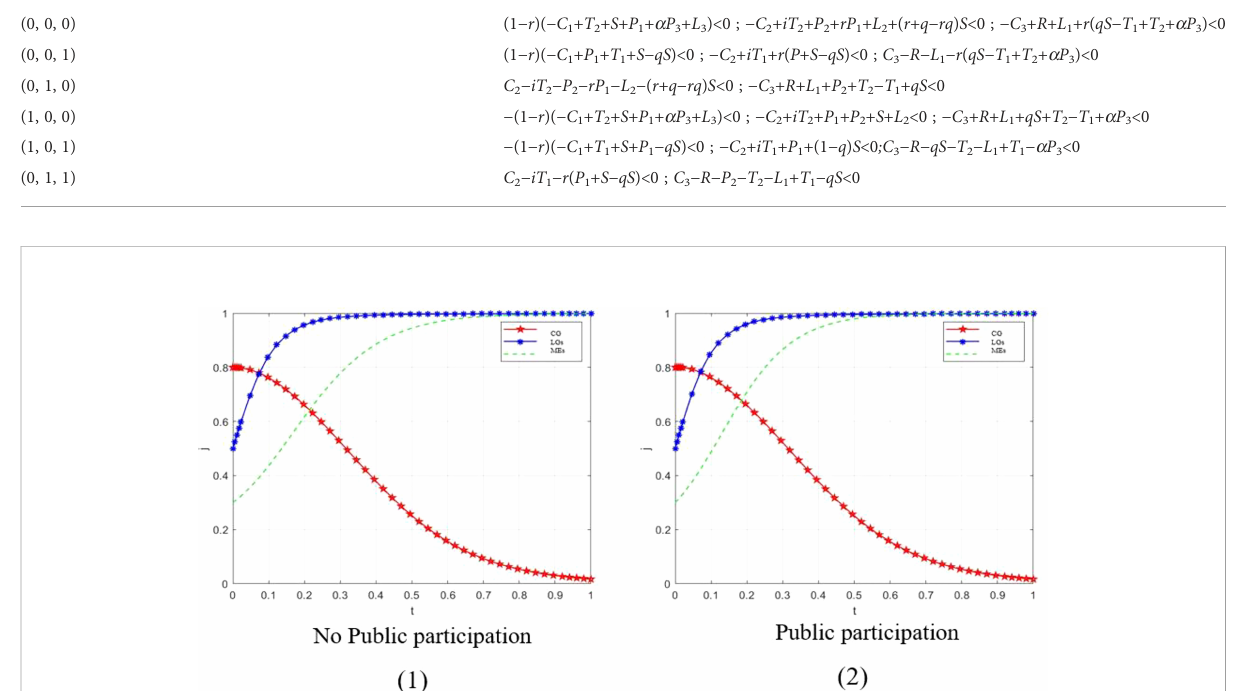
FIGURE 9 The impact of public participation on the